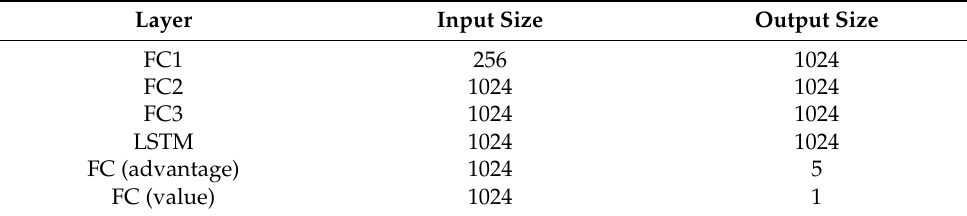
Table 3. Parameter Setting for the Decision